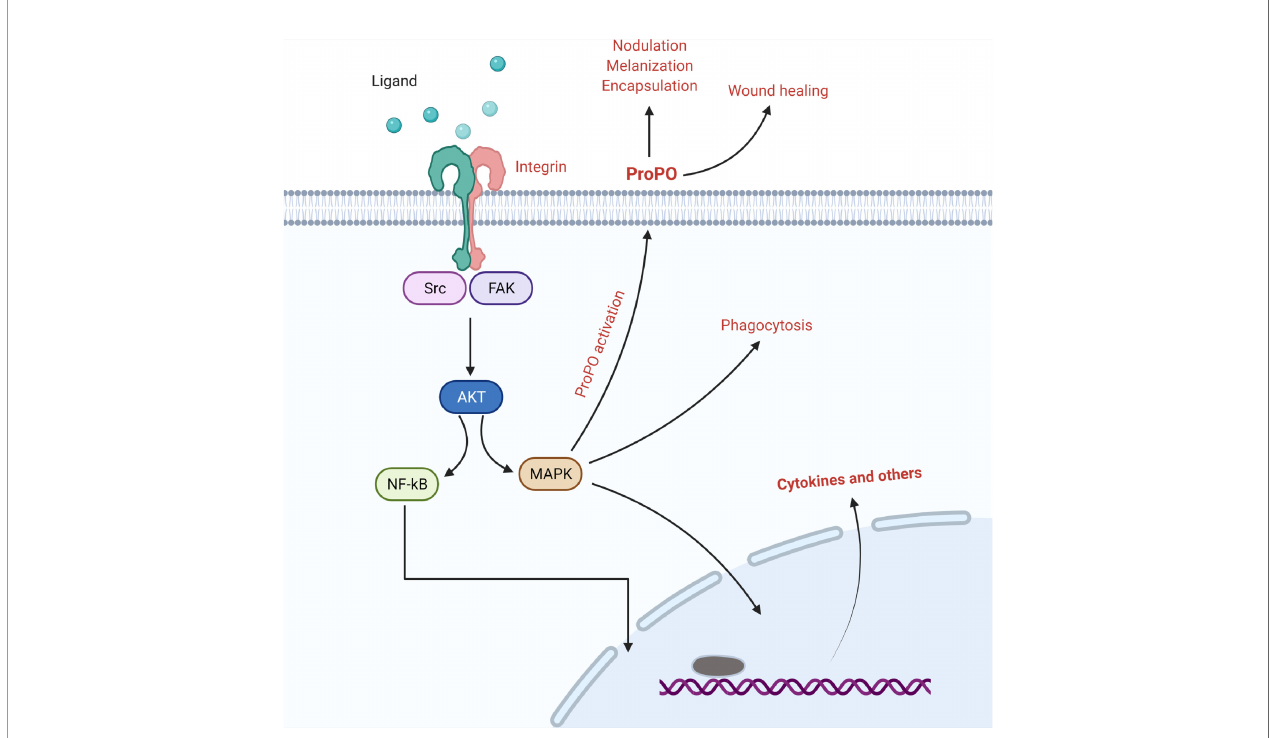
FIGURE 2 | The involvement of integrins in the regulation of nodulation, melanization, encapsulation, and wound healing via focal adhesion kinase and its associated